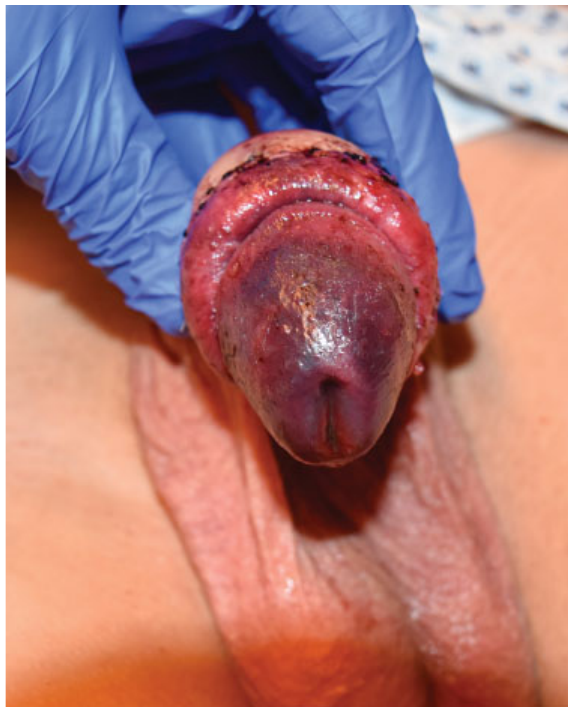
Fig. 1 Glans with severe ischemia on the fi rst postoperative day (admission).